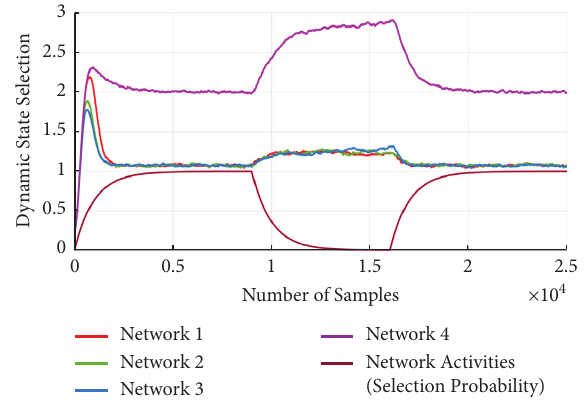
Figure 26: Effect of noise � 0.01 W on network connectivity for threshold � 2 and sensitivity � 5.